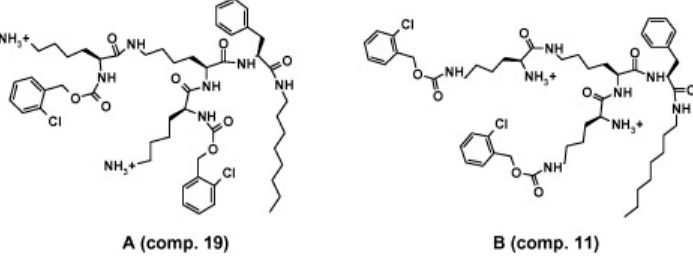
Figure 6. General structure of antifungal lipopeptides developed by Zofia Urbánczyk-Lipkowska and colleagues: ( A ) More branched (Compound 19); and ( B ) less branched (Compound 11). From [42]. Reproduced with permission.